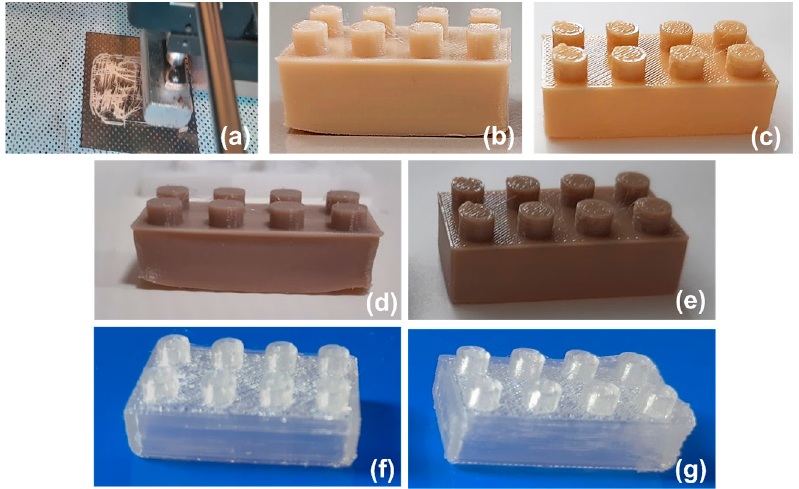
Figure 1. Attempts to print: V-PLA filament at 180 °C ( a ), 190 °C ( b ), and 210 °C ( c ); R-PLA at 190 °C ( d ) and 210 °C ( e ); L-PLA at 190 °C ( f ) and 210 °C ( g ).